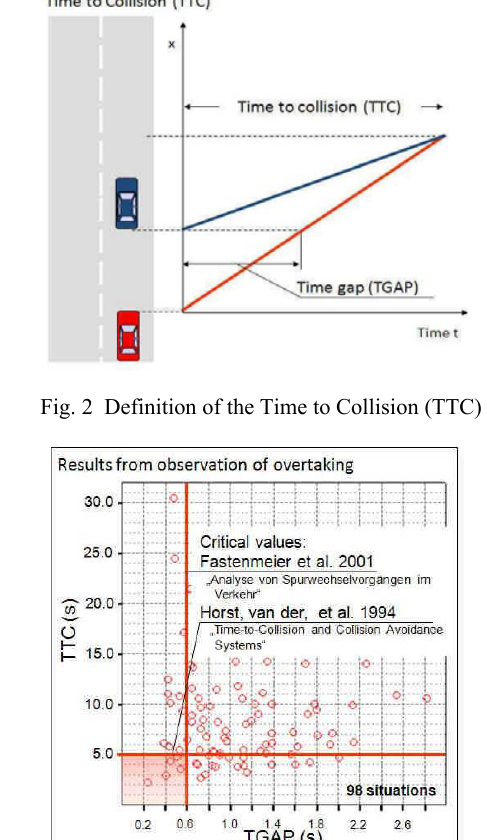
Fig. 1 Geometry defining the Time to Line Crossing